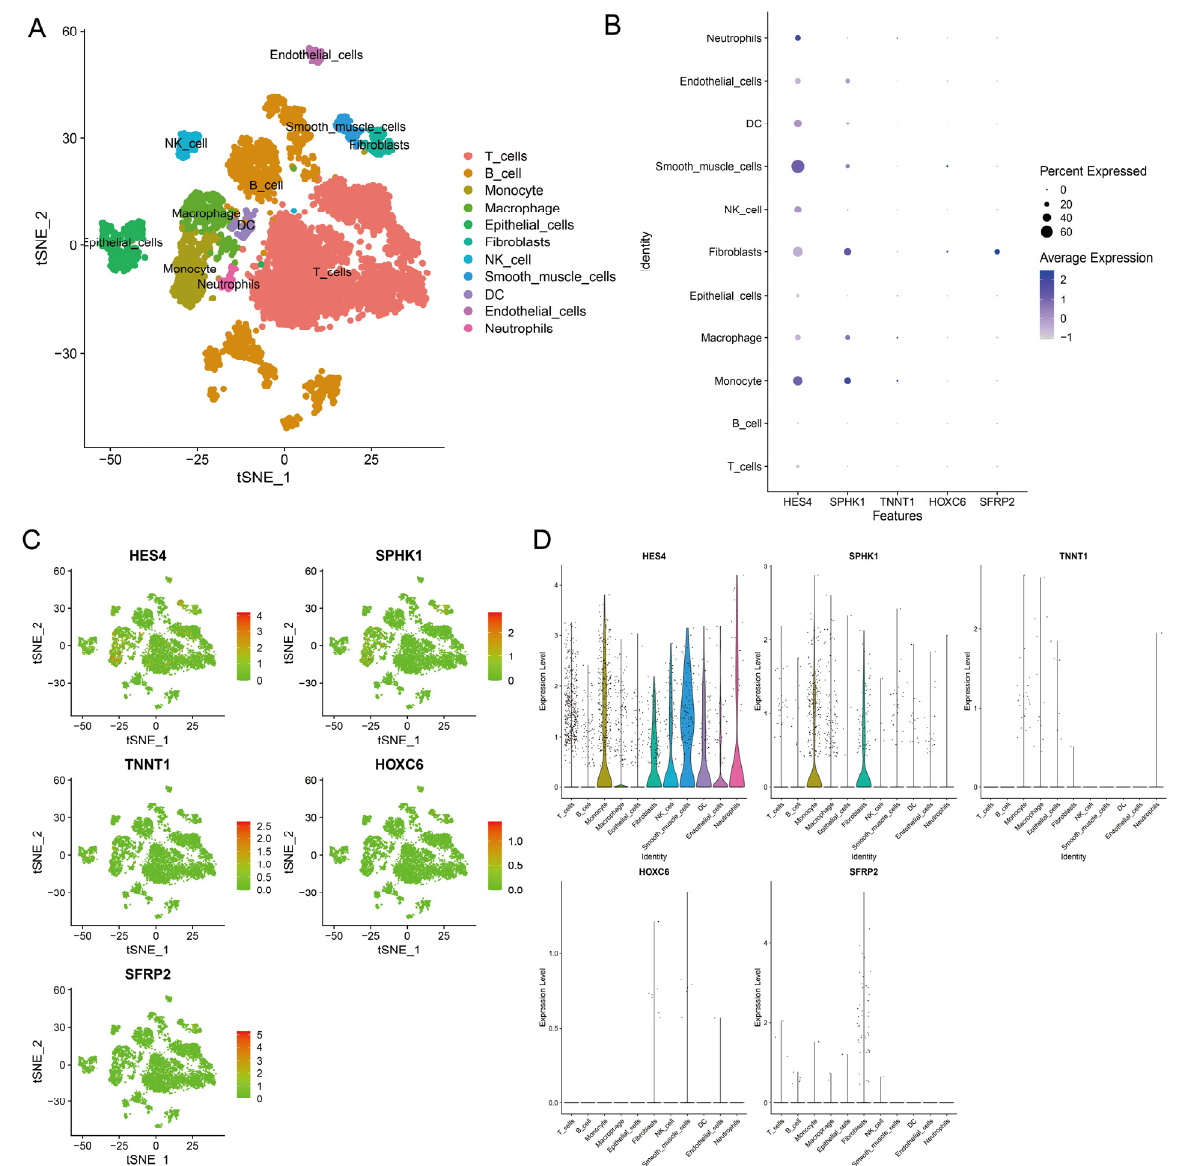
Figure 8. CRC single-cell profiles. ( A ) tSNE plots for 11 cell types. ( B ) The bubble plots show the expression levels of model-built genes in all cell types. ( C ) The tSNE plots show the expression levels of model-built genes in all cell types. ( D ) The violin plots show the expression levels of model-built genes in all cell types.